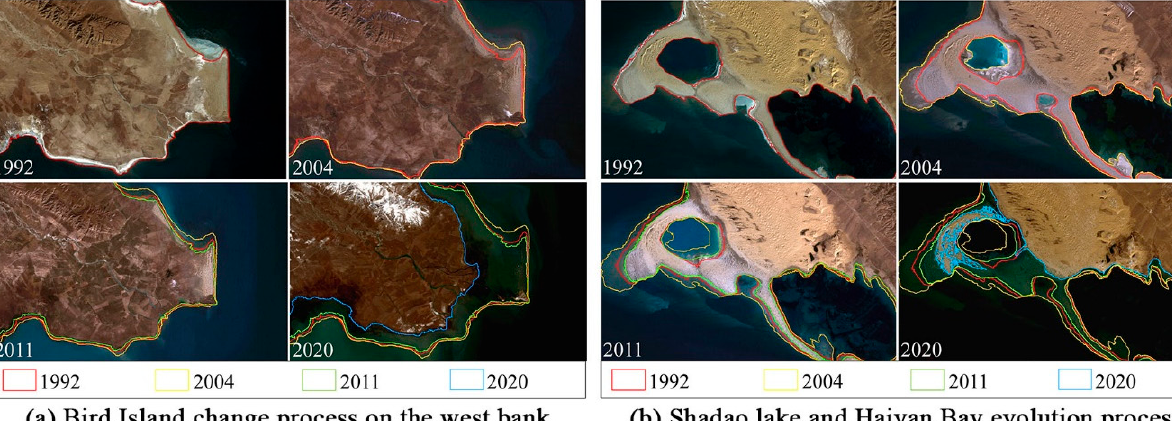
Figure 5. Shoreline change detection using Landsat images from 1992 to 2020.